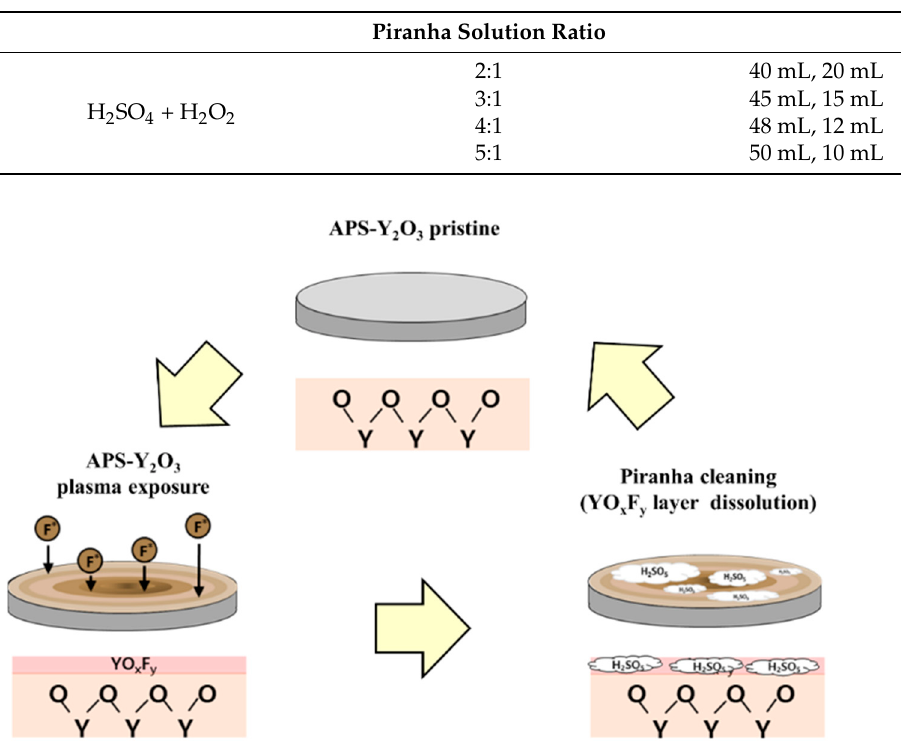
Table 2. Details of the piranha solution ratio.